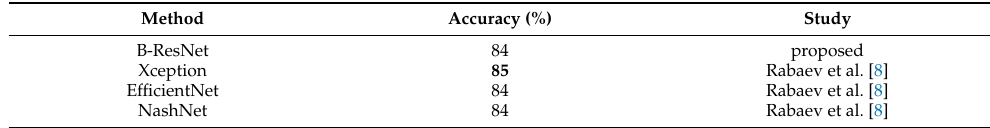
Table 4. Gender prediction accuracy on the HHD